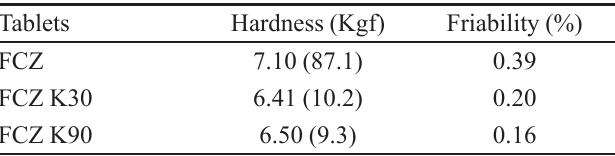
TABLE IV – Hardness and friability data of tablets produced with fluconazole (FCZ) and granules (FCZ K30 and FCZ K90). N=20